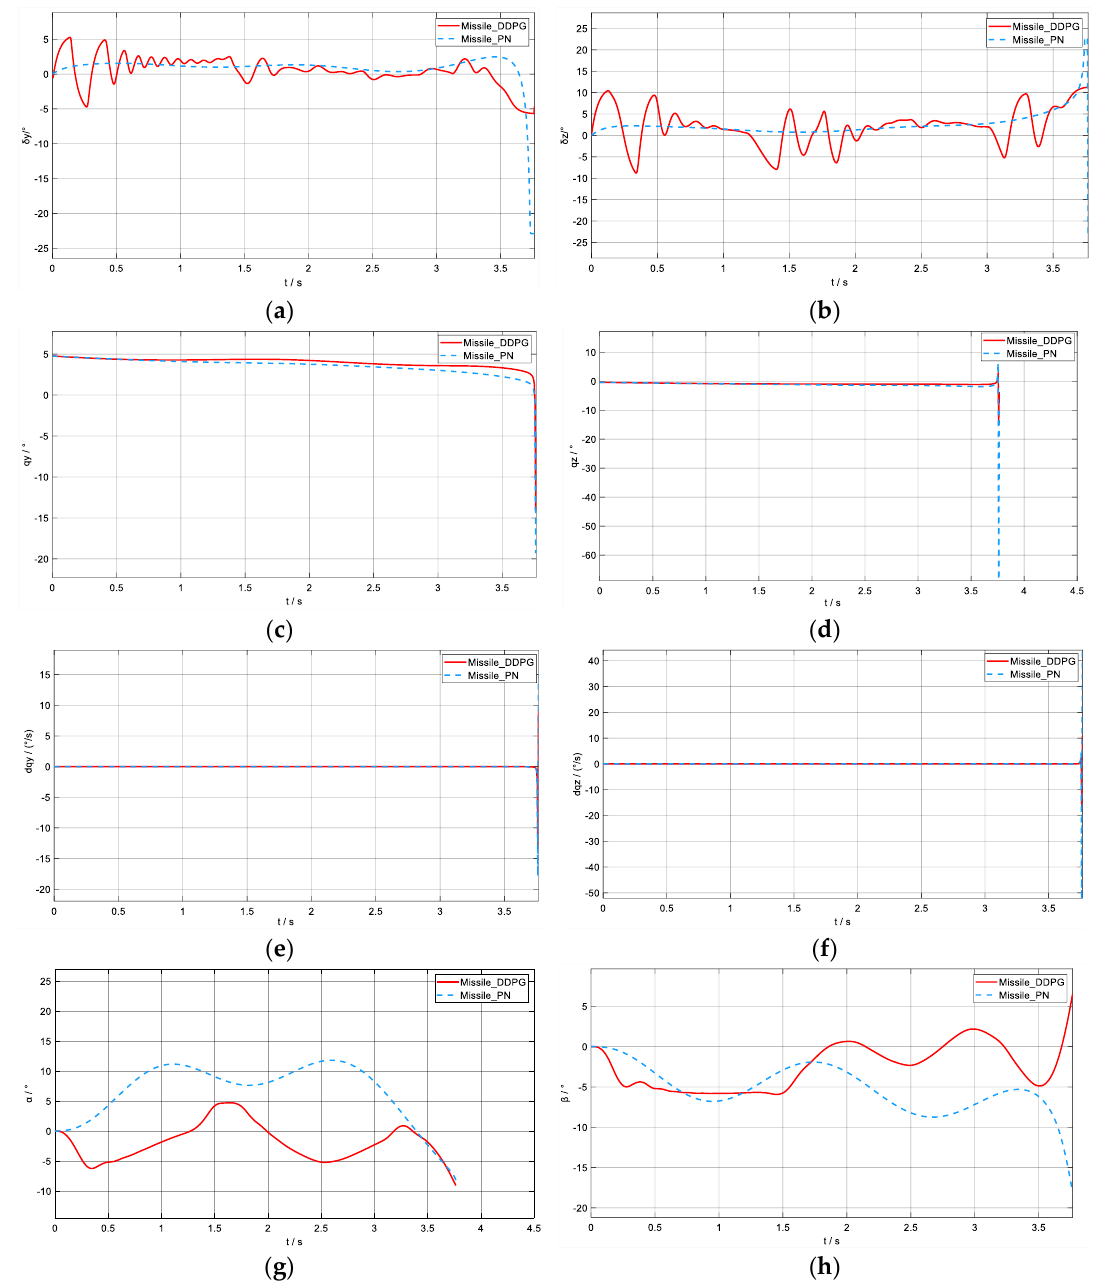
Figure 7. Ballistic curve: ( a ) and ( b ) are the lateral and elevated fin − deflection curves; ( c ) and ( d ) are the line − of − sight angles (y and z directions); ( e ) and ( f ) are the line − of − sight angular velocities (y and z directions); ( g ) and ( h ) are the angle − of − attack curve and sideslip − angle curve, respectively (Scenario 2).